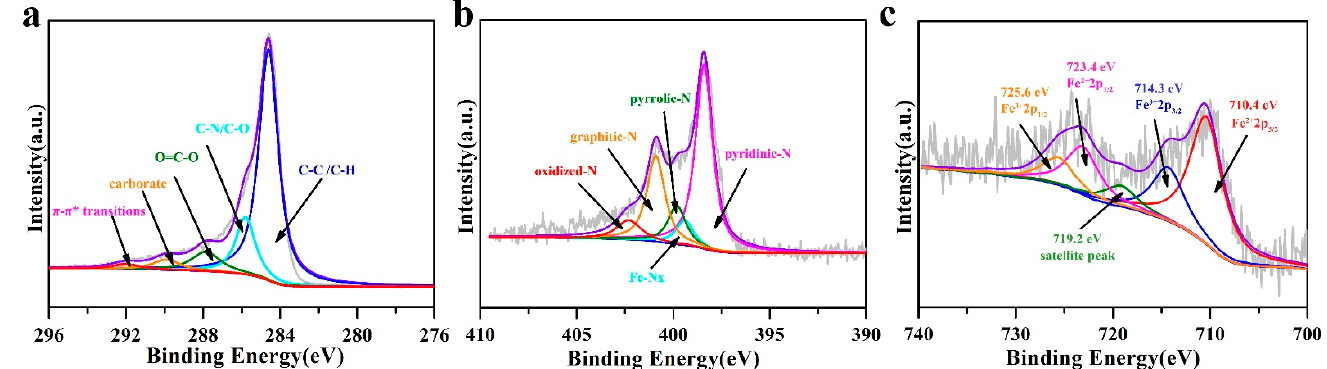
Figure 5. XPS spectra of Fe–N/C–0.05–900: ( a ) C 1s, ( b ) N 1s, and ( c ) Fe 2p.